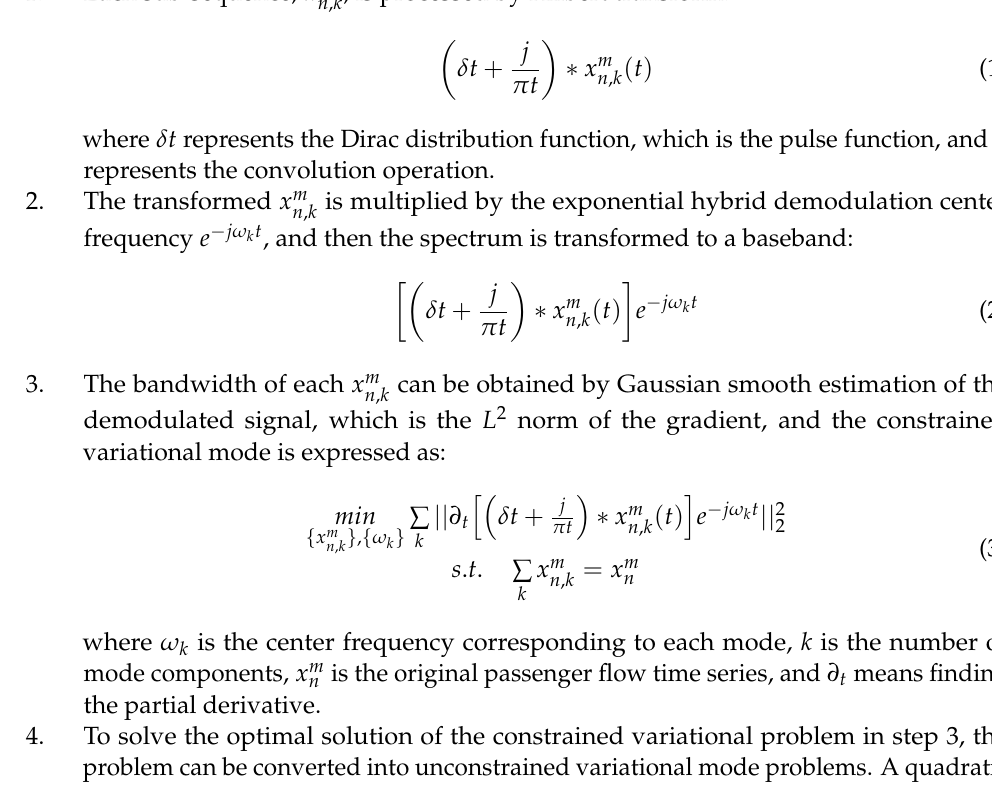
Figure 2. Passenger flow time series prediction process.